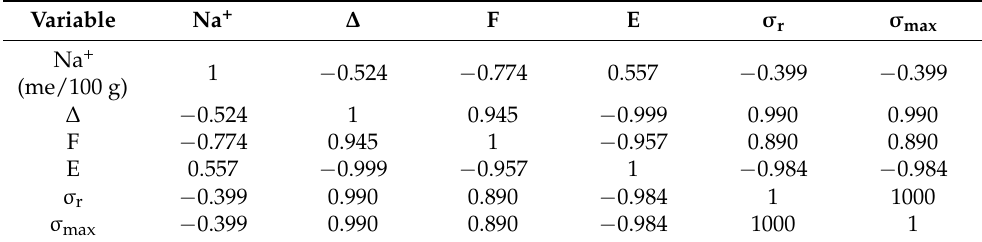
Table 8. Na + correlation coefficients–axial effort (Pearson correlation matrix).